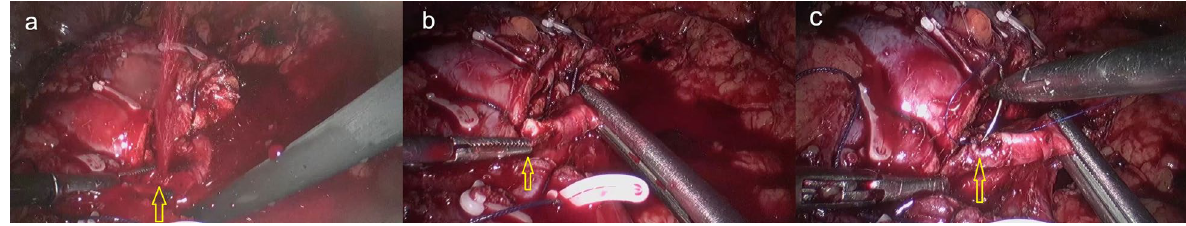
Fig. 6 a Bleeding from the segmental renal arterial tear after hilar unclamping (marked with yellow arrow). b Arterial tear with ragged edges noticed after selective segmental artery clamping (marked with yellow arrow). c Repair of arterial injury with prolene (marked with yellow